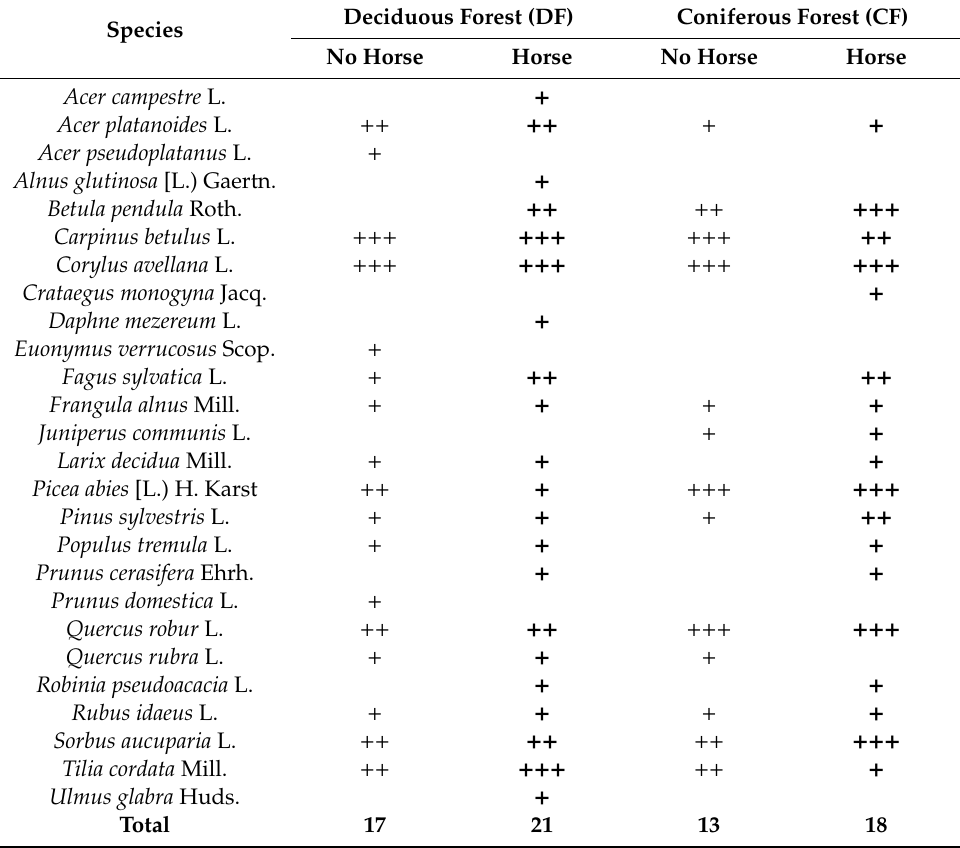
Table 3. The share of species in the understory and undergrowth higher 0.5 m layer with the presence or absence of the Polish primitive horse. Abbreviations—see Table 1. Areas with horse were bold coded for ease of